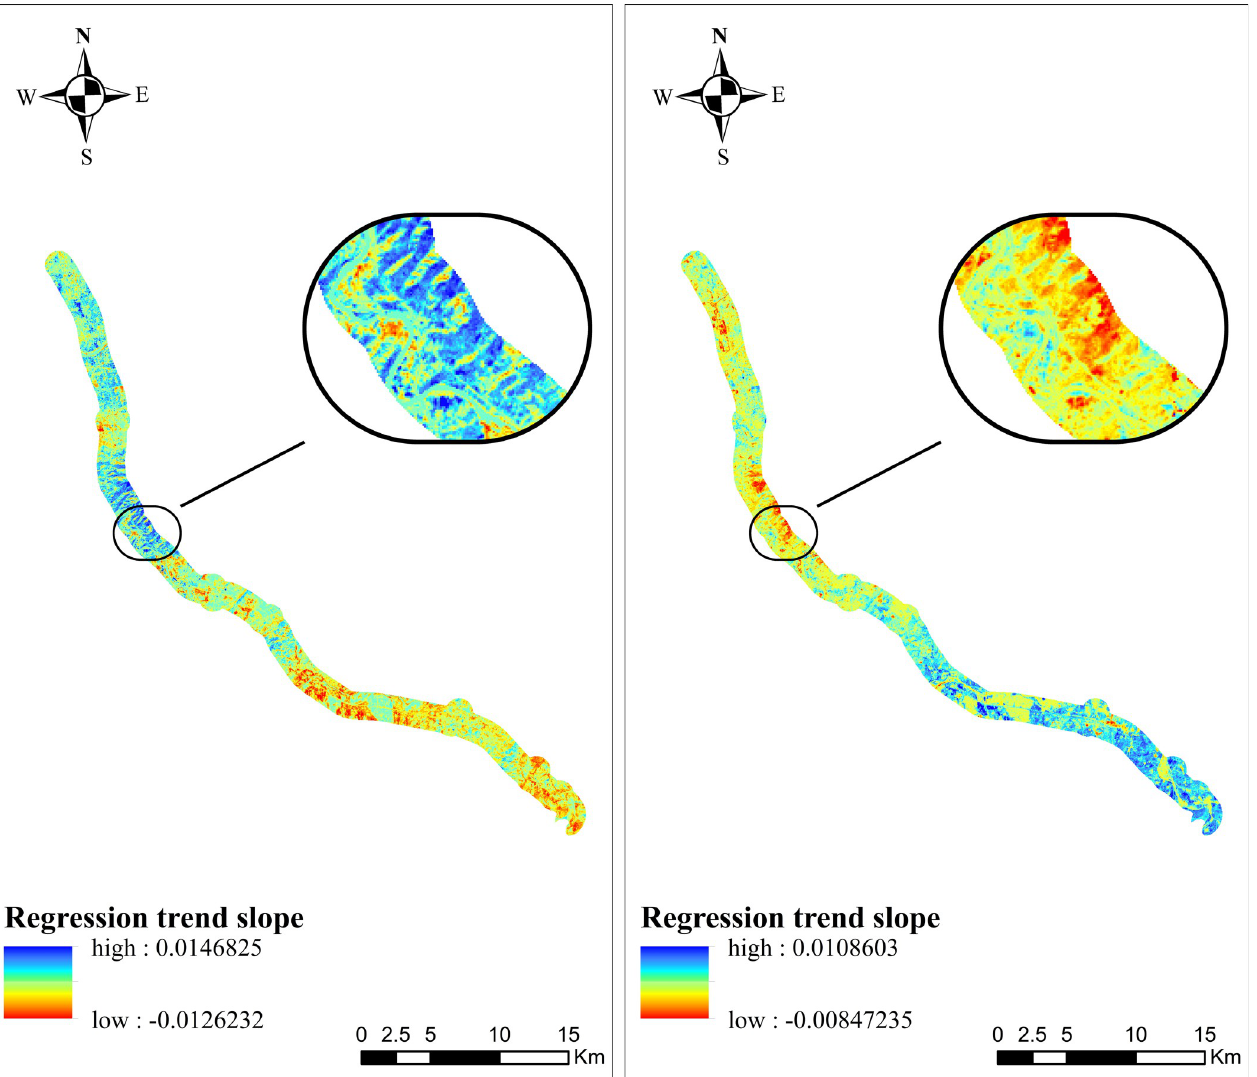
Fig 12. Trend of multi-year VSWI spatial distribution in the buffer zone of Jinliwin Expressway. ( a ) Average trend of 2008–2010 (during construction) ( b ) Average trend of 2010-2016(finished).